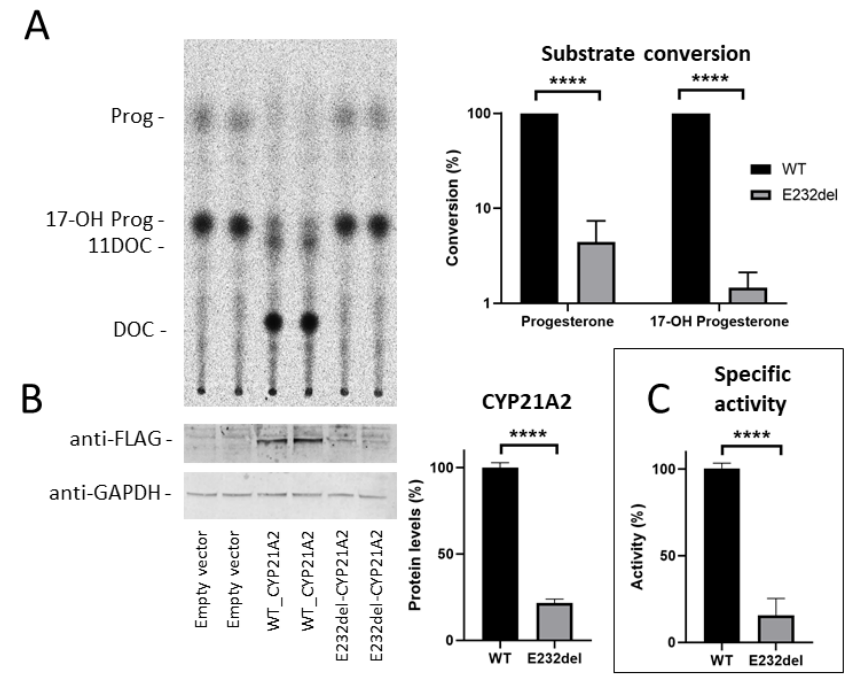
Figure 2. CYP21A2- E232del affects protein levels and 21-hydroxylase activity. Legend: ( A ) Left-hand panel: thin layer chromatography (TLC) shows that E232del variant markedly reduces the hydroxylase activity of CYP21A2. Right-panel: substrate conversion is calculated after densitometric quantification of the relative incorporation of radioactivity in specific TLC spots. Conversion of progesterone (Prog) to 11-deoxycorticosterone (11DOC) in the mutated protein ( E232del -CYP21A2) is reduced to an average of 4% compared to the wild-type form of the protein (WT-CYP21A2). Conversion of 17-hydroxyprogesterone (17-OH Prog) to 11-deoxycortisol (DOC) is reduced to an average of 1%. ( B ) Left panel: Western blot analysis of protein levels following overexpression of CYP21A2 in non-steroidogenic COS1 cells shows reduced expression of the protein carrying the E232del variant compared to the wild-type form. Right panel: densitometric quantification of the blot indicating that E232del mutation reduces CYP21A2 expression to 22% on average. ( C ) Relative specific activity was calculated by dividing the values of substrate conversion (Panel A) by the paired protein level values (Panel B). The E232del variant then reduces CYP21A2-mediated activity to 16% on average. Statistical analysis was conducted as described in the Methods section. The bars in Panel A were analyzed using a two-way ANOVA analysis followed by post hoc Sidak’s multiple comparison test. The bars in Panel B were analyzed using a two-tailed Student’s t -test. The bars in Panel C were analyzed using a two-tailed Welch t -test. The error bars indicate the standard error of the mean (SEM). Every experiment was run with three independent biological replicates, each time using technical triplicates. ****, p ≤ 0.0001.